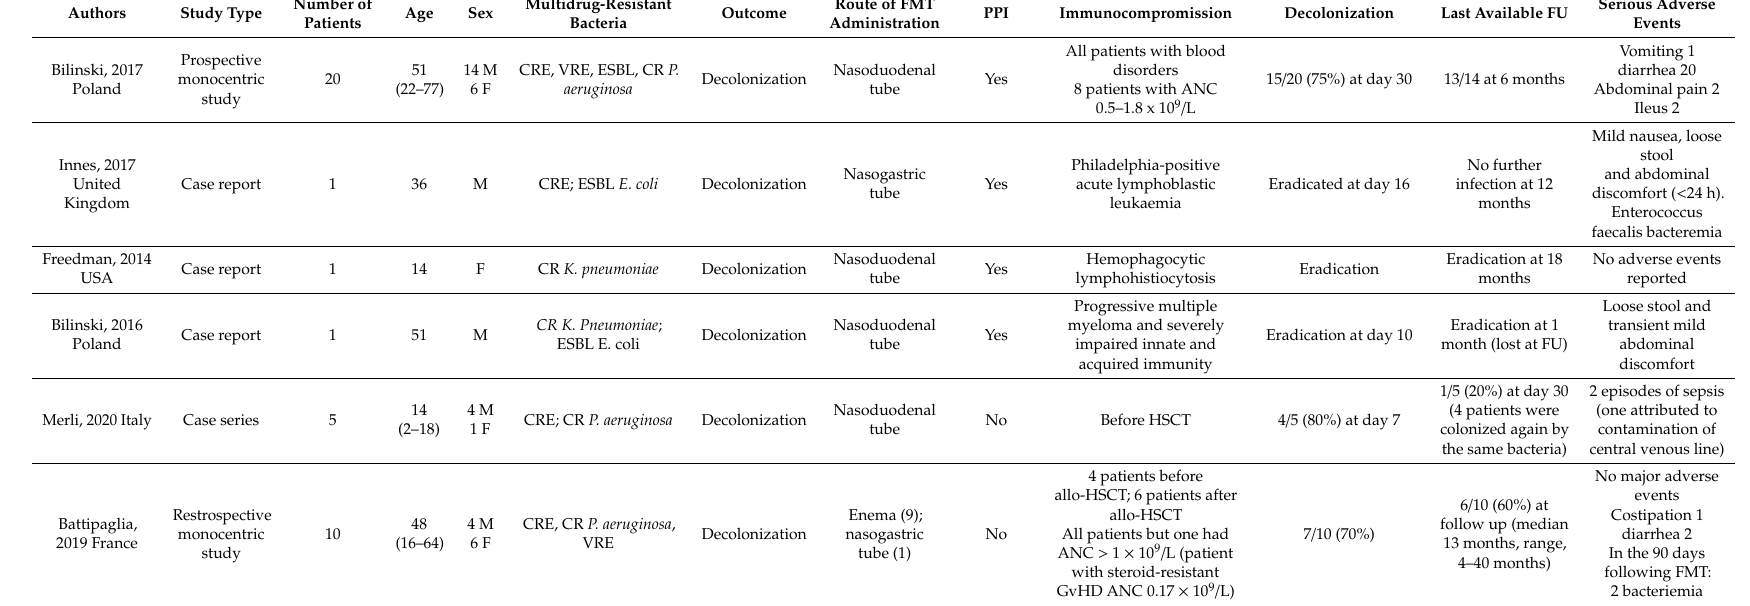
Table 2. FMT for MDR decolonization in patients with hematologic